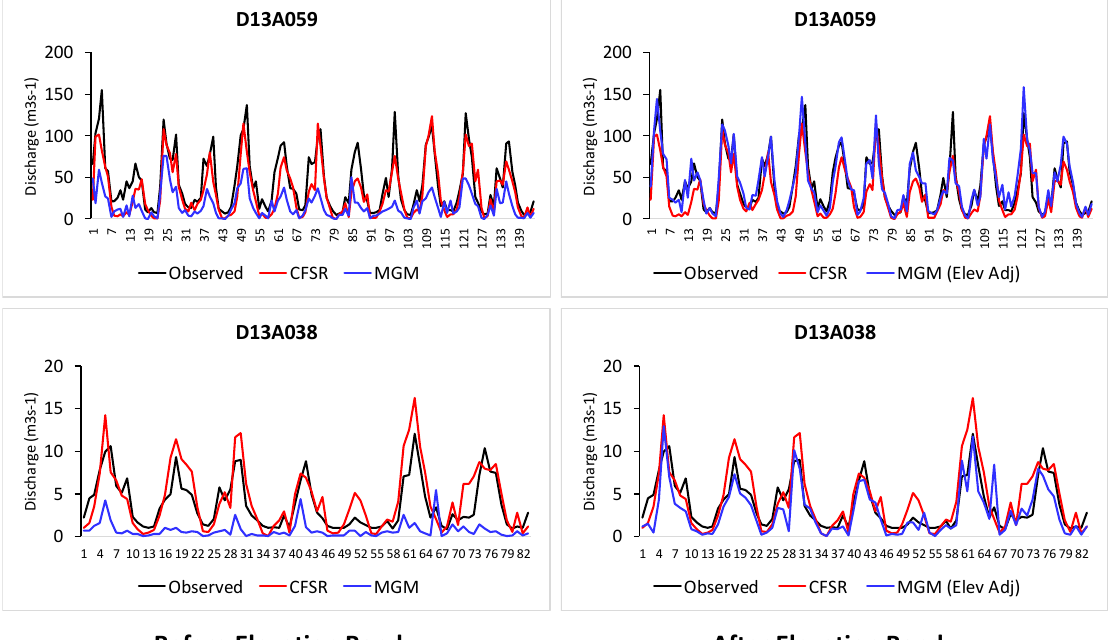
Figure 10. Simulated streamflow (for DA13A059 and D13A038) after the application of elevation bands using the local climate data. Hydrographs on the right-hand side shows the model results after elevation band application. Table 4. Model performance improvement on uncalibrated SWAT simulations by the application of elevation bands (including full-time period for each gauge stations) to the local climate datasets. R